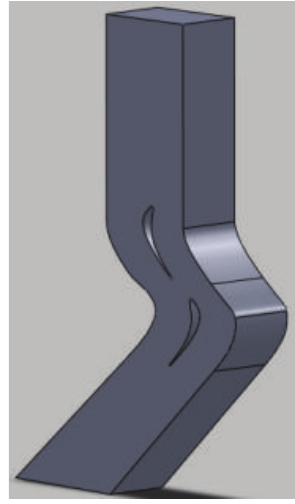
Figure 8: The single-period model in SolidWorks.